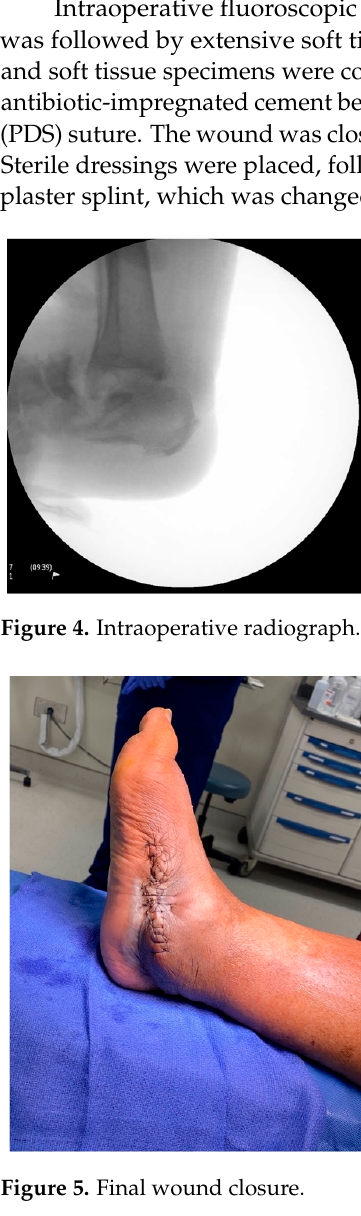
Figure 3. Talus extraction.